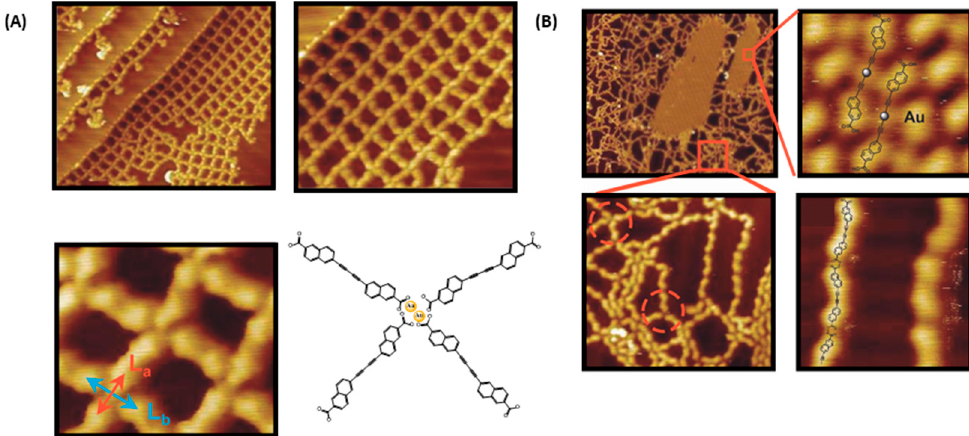
Figure 24. Polymerization of 6-ethynyl-2-naphthoic acid (ENA) by a domino reaction based on the Glaser coupling/dehydrogenative coupling combination. ( A ) STM topographs obtained at low density of molecules after Glaser coupling and formation of the Au-carboxylate complex on Au(111) substrates (left: 42 nm × 38 nm, right: 21 nm × 17 nm, bottom: 5.9 nm × 5.0 nm). ( B ) STM topographs obtained at high density of molecules on Au(111) substrates (top left: 72 nm × 88 nm, top right: 2.6 nm × 1.2 nm, bottom left: 17 nm × 12 nm, bottom right: 5 nm × 4 nm). Reprinted with permission from Held et al. [125]. Copyright © 2016 John Wiley & Sons, Inc.